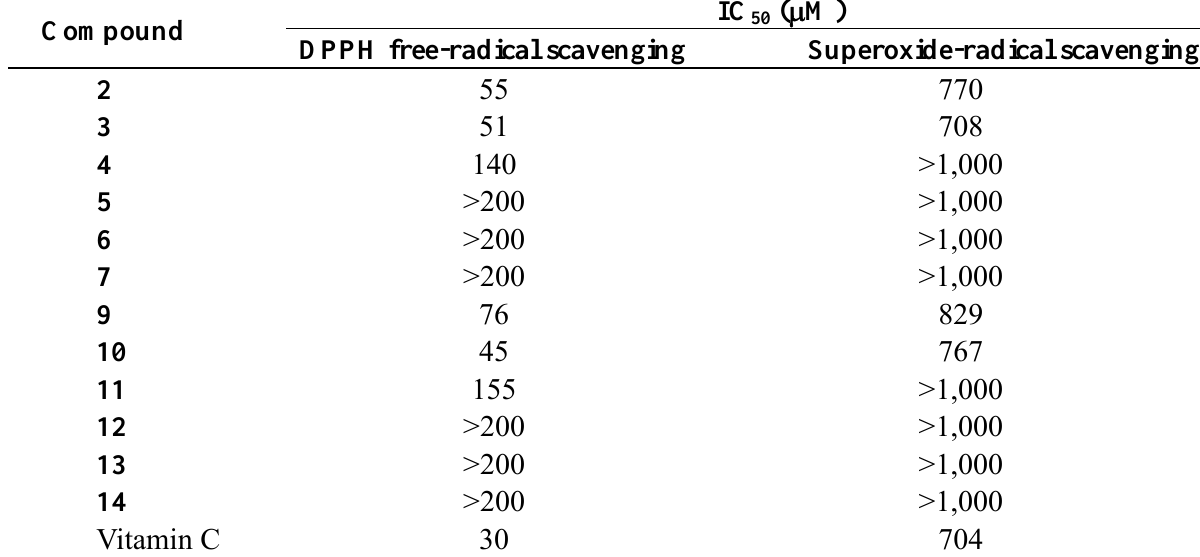
Table 2. Antioxidant activities of glycitein β -glycosides 2 - 7 and daidzein β -glycosides 9 - 14 .